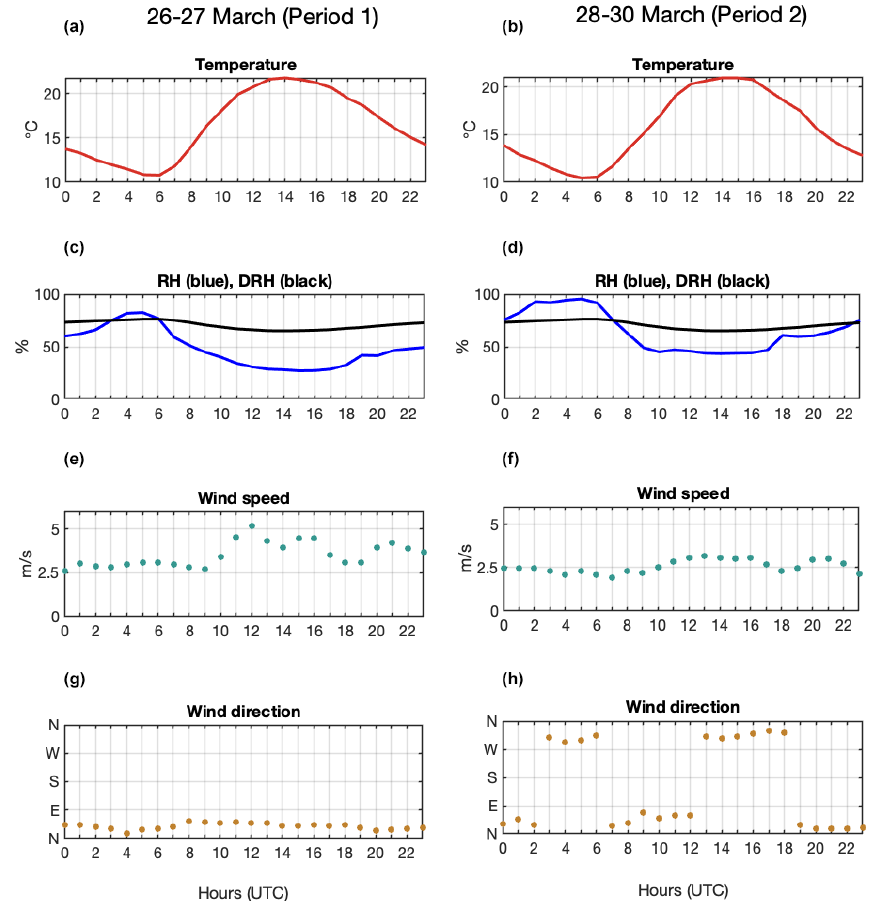
Figure 8. Hourly median surface temperature (in ◦ C) (a, b) , relative humidity (blue) and calculated deliquescence relative humidity (DRH; black) (in %) (c, d) , wind speed (in ms − 1 ) (e, f) , and wind direction (in degrees) (g, h) are presented in (a, c, e, g) for period 1 and in (b, d, f, h) for period 2. Although temperature and relative humidity measurements originate from OASIS, wind speed and wind direction data originate from the SIRTA